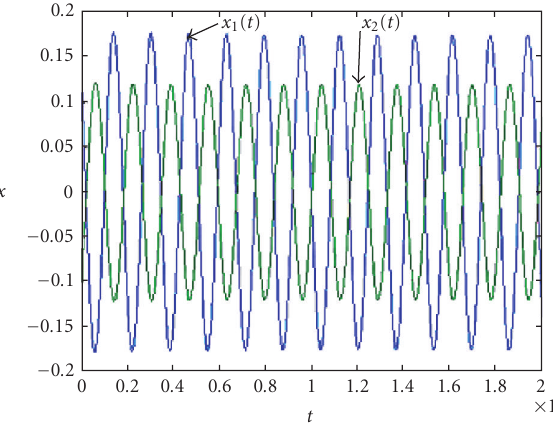
Figure 4.4. Time response of state variable x 1 (t) for system (4.1) under a 1 = 1 . 75, a 2 = 0 . 5, b 1 = 0 . 2, b 2 = − 0 . 4, τ = 18, σ = 0 . 5 τ